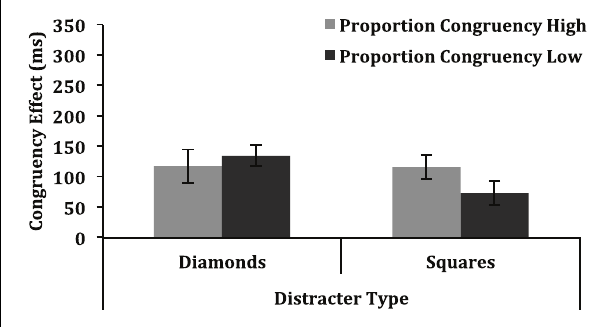
FIGURE 2 | Congruency effects (mean incongruent RT—mean congruent RT) in Experiment 1 are depicted as a function of proportion